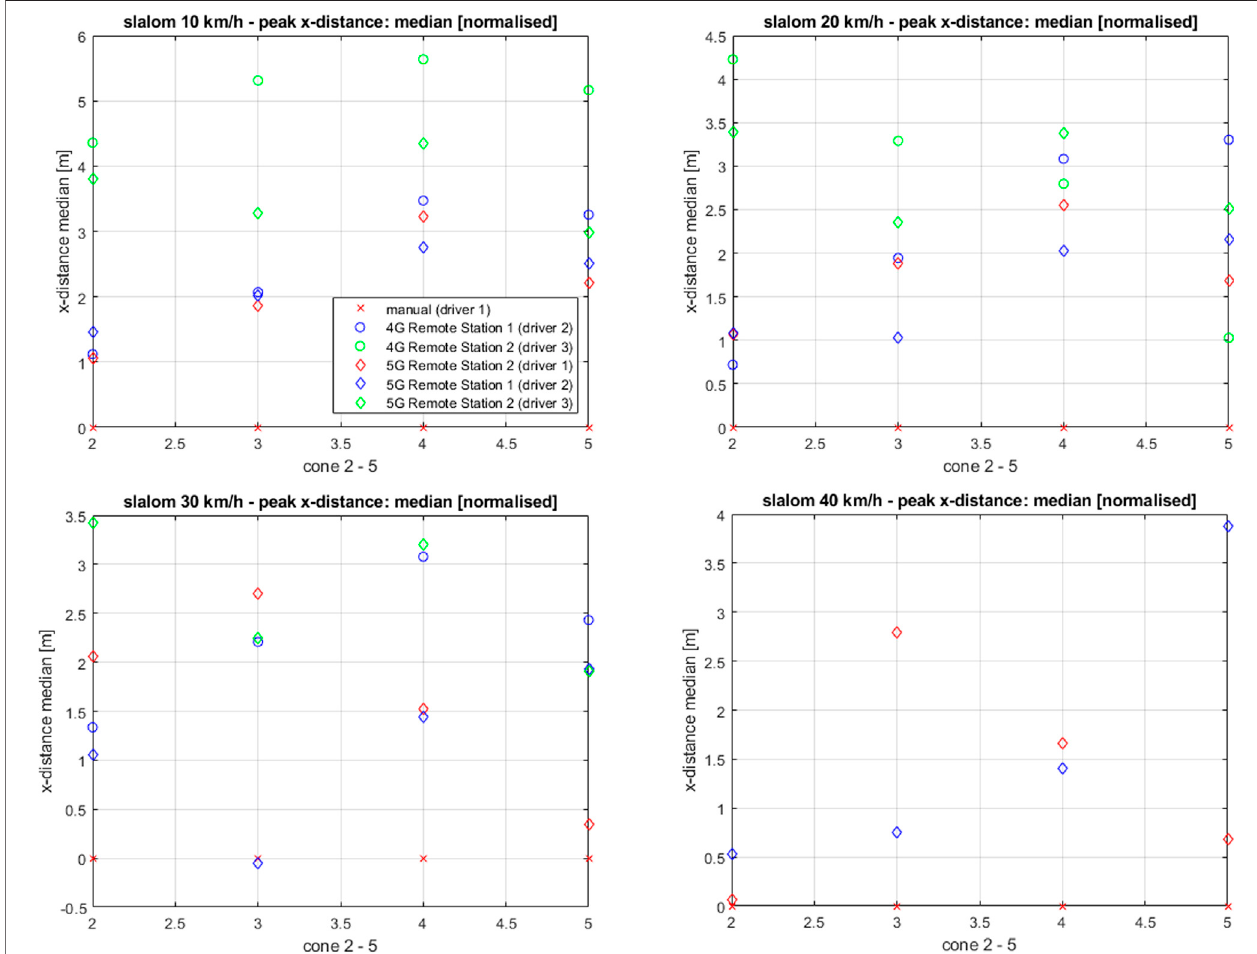
FIGURE 10 | Deviation in x-distance from remote drivers with respect to the manual driver at 10, 20, 30, and 40 km/h (normalized to the x-position of the manual driver). Driver 1 has driven the vehicle manually as well as remotely to provide a benchmark.